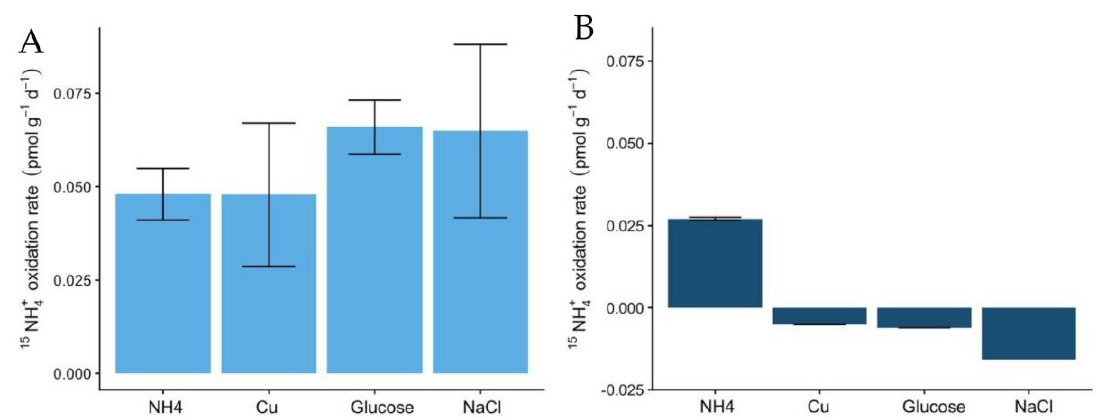
Figure 4. Potential ammonia oxidation rates (pmol g −1 d −1 ) using labelled 15 NH 4 + to a final concentration of 4 µM in Miers ( A ) and Beacon Valleys soils ( B ) for the following treatments: ammonium augmentation (NH 4 + ), Cu and glucose amendments, and conductivity treatment. Error bars indicate the standard variation in the rates measured of two replicates.